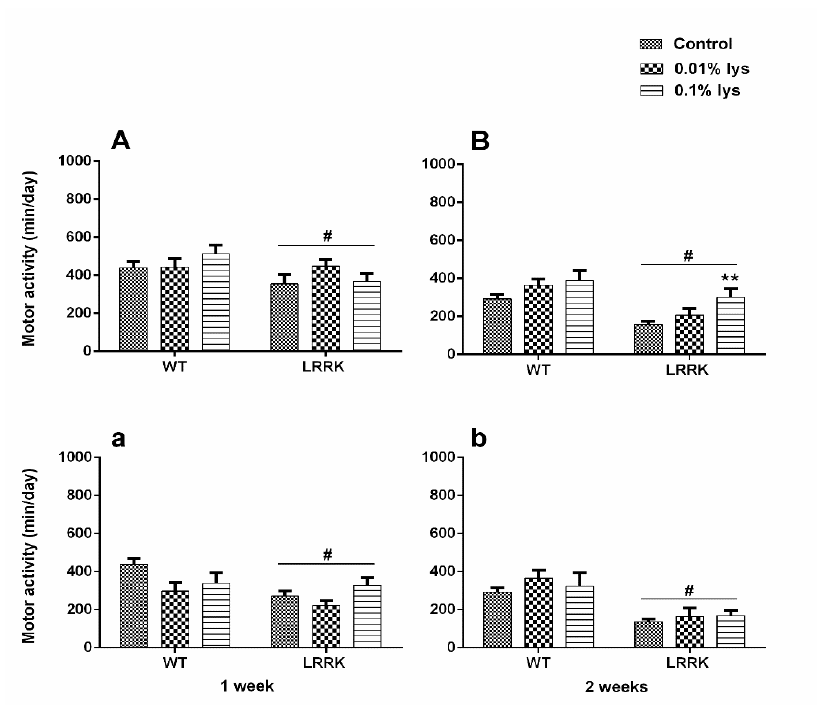
Figure 1. Effects of male dialyzable leukocyte extracts (mDLE) and female dialyzable leukocyte extracts (fDLE) treatments on motor activity of wild-type (WT) and LRRK mutant flies. Total motor activity (24 h) of WT and LRRK mutant flies treated with mDLE ( A , B ) or fDLE ( a , b ) in their diet at 7 days and 14 days is shown. Bars represent mean ± standard error of mean (SEM) of 20 – 40 fly groups in triplicate. # = p < 0.01 LRRK strain versus WT group and ** = p < 0.001 LRRK C versus LRRK fDLE (0.1%).